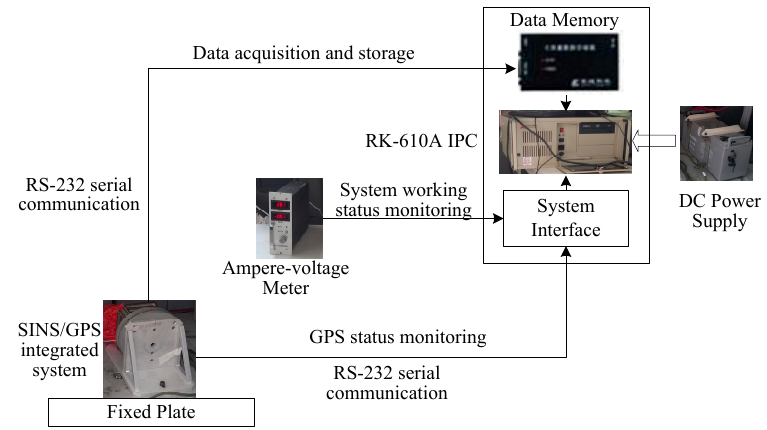
Figure 2. The framework of the experimental system.